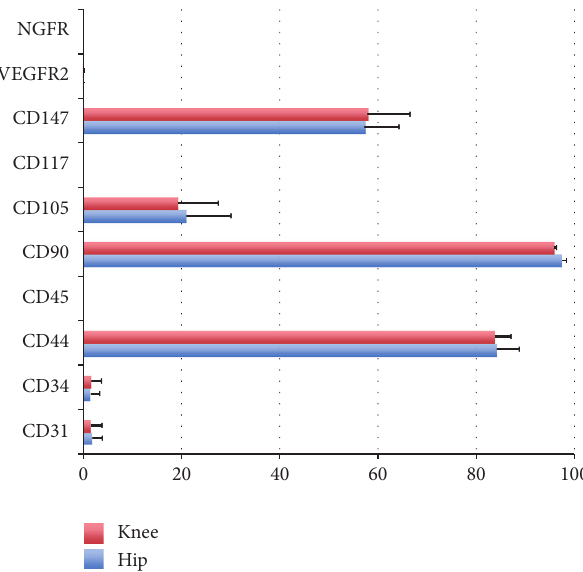
Figure 8: Flow cytometry analysis of the expression of cell surface markersrelatedtostemcells,hematopoieticstemcells,andendothe- lial cells in each population of cells derived from each sample. Passage-2 cells from 3 donors were examined, and similar results were obtained. Positive expression rates are